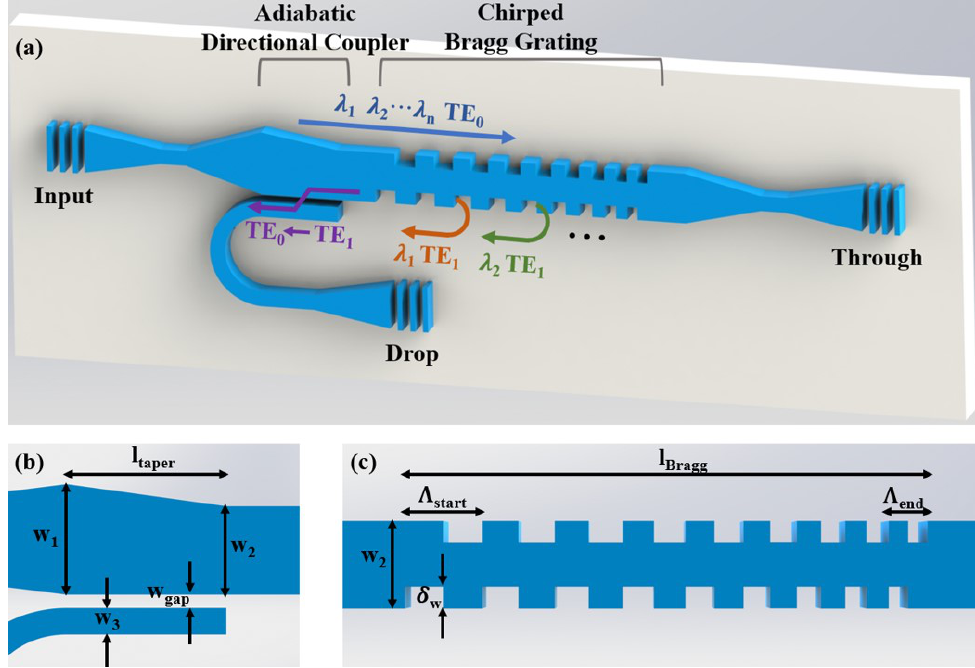
Figure 1. ( a ) Schematic view of the proposed mode-conversion based chirped Bragg grating on TFLN. Schematic views of the adiabatic directional coupler ( b ) and the chirped Bragg grating ( c ) with design parameters labeled out.